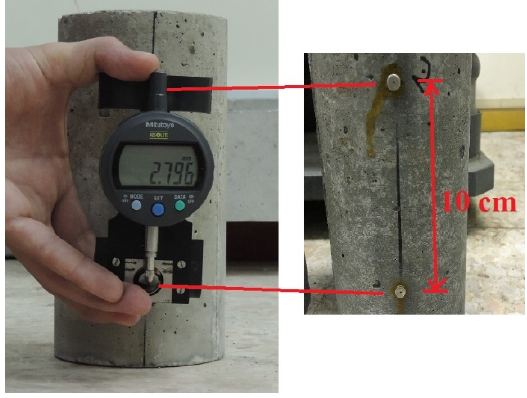
Figure 3. Drying shrinkage test setup.